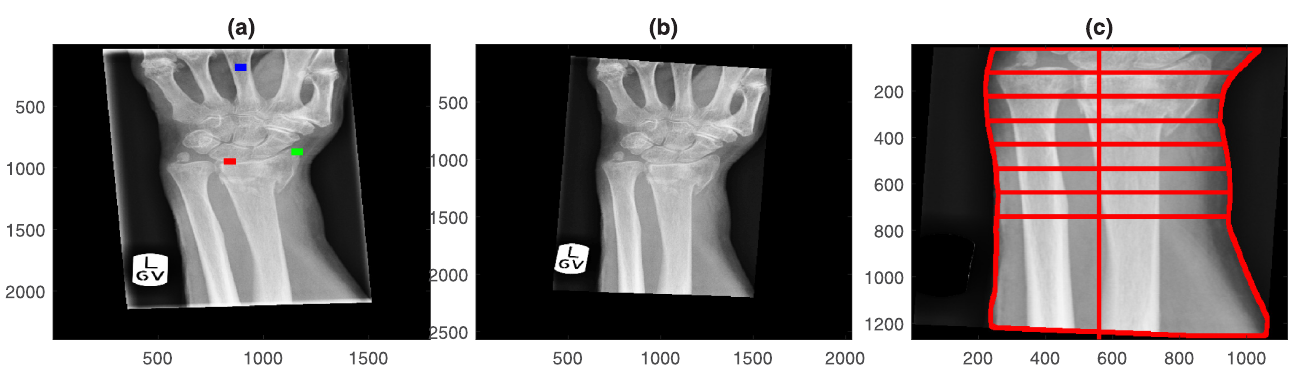
Fig 6. Semi-automatic extraction of measurements of the forearm. (a) Original radiograph that presents rotation of the arm and artefactual lines due to the collimator. Three landmarks have been manually located in the base of the lunate (red), radial styloid (green) and centre of the middle finger (blue). (b) Automatic pre-processing of the image where the forearm was aligned vertically and the lines removed. (c) Using the lunate landmark as a guide, the boundaries of the forearm were automatically delineated and lines traced between the boundaries. The distance between the lines is 1 cm and were being used to derive swelling measurements of the wrist.